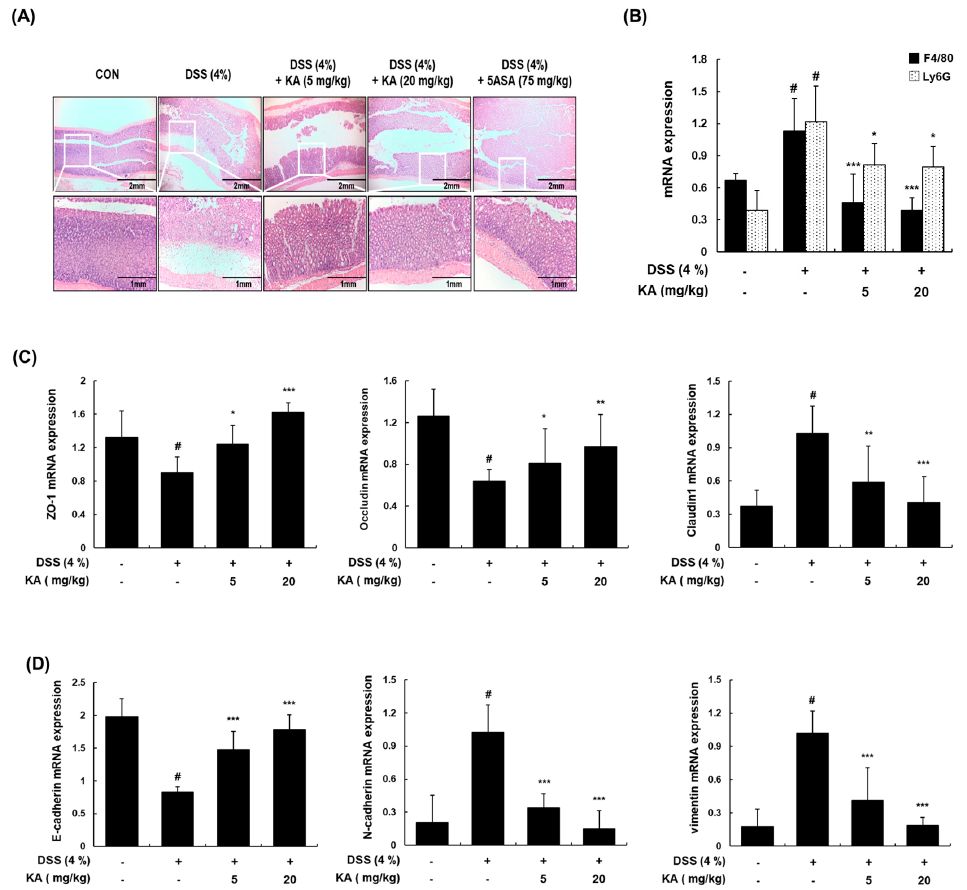
Figure 7. Effects of KA on histological changes and the expression of tight junction (TJ)- and epithelial–mesenchymal transition (EMT)-related markers in DSS-induced colonic tissues. ( A ) Representative sections of colon tissues from mice administrated with 4% DSS in drinking water for 7 days with KA (5 or 20 mg/kg/day, i.p.). 5-ASA (75 mg/kg/day, p.o.) was used as a positive control.